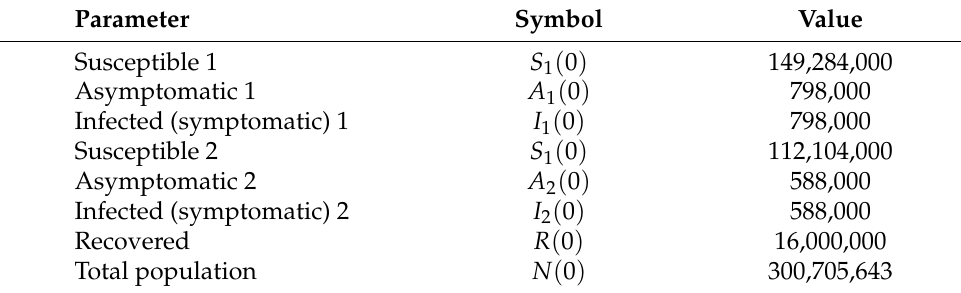
Table 1. Initial conditions for the